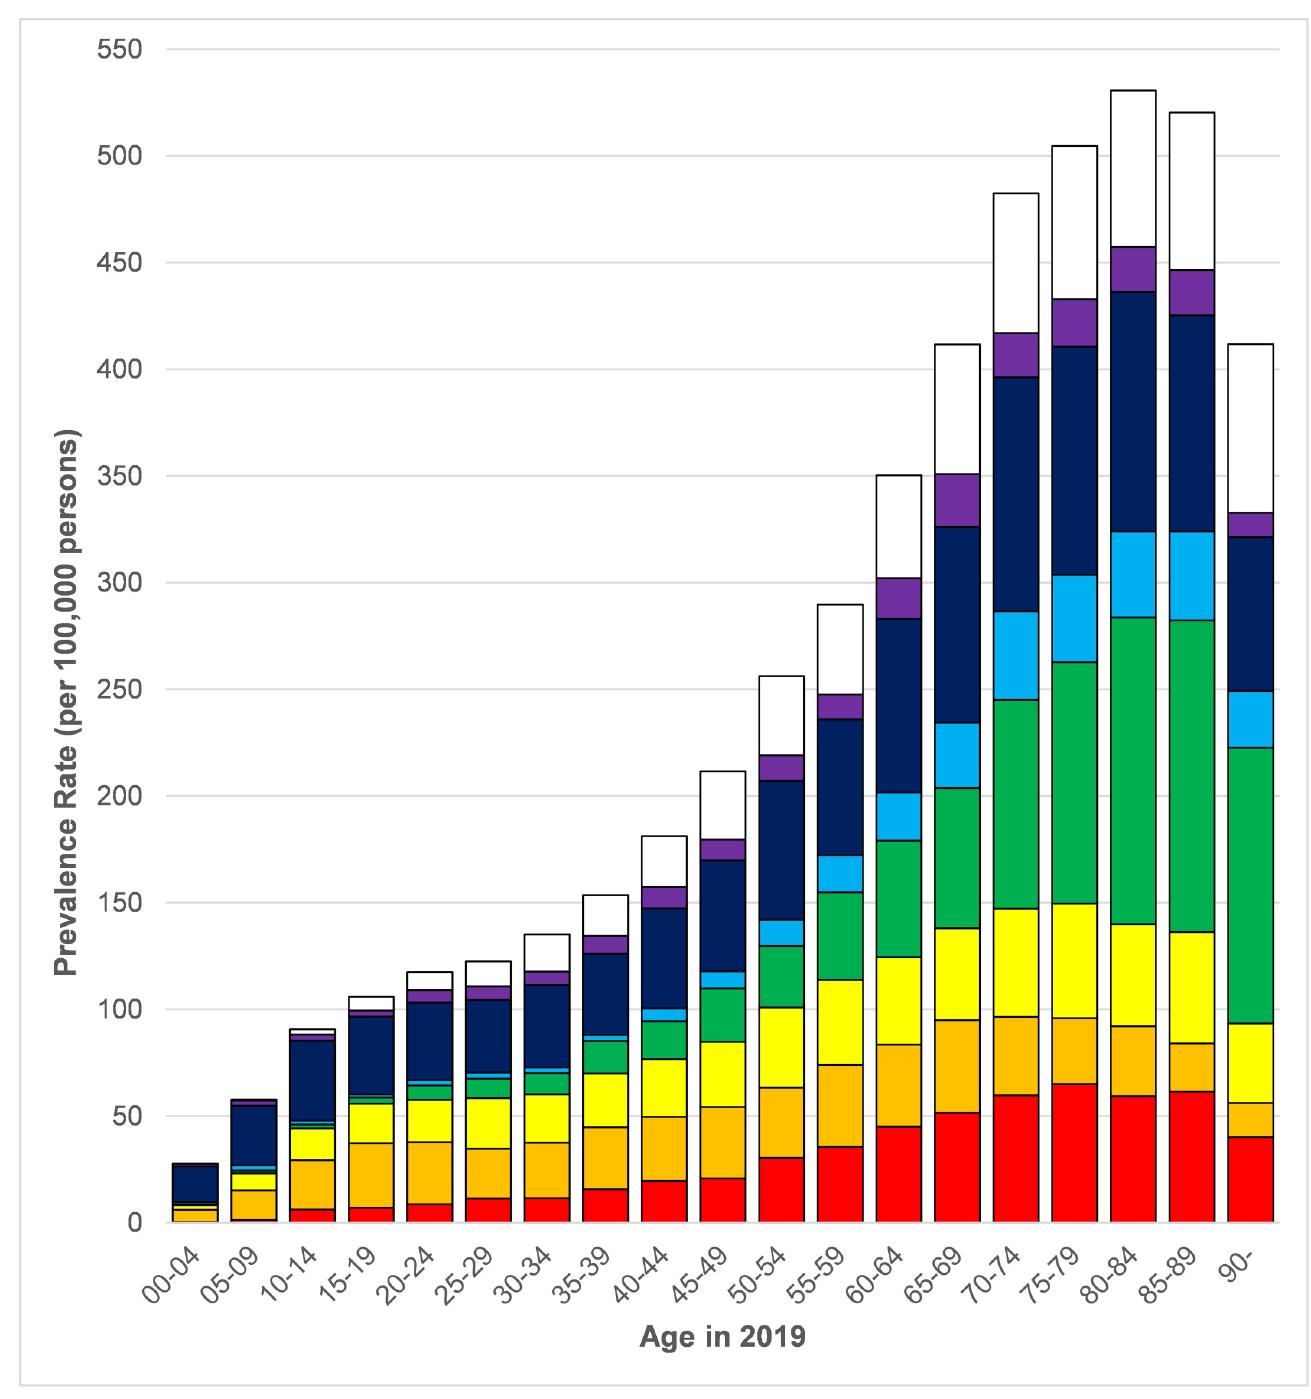
Fig 1. Prevalence rates per 100,000 persons in 2019 by 5 year-age group and type of neuromuscular disease. Red = Inflammatory myopathies, Orange = Muscular dystrophies, Yellow = Charcot-Marie Tooth disease, Green = Myasthenia gravis, Light Blue = Motor neurone disease, Dark Blue = Other neuromuscular disease, Purple = Guillain-Barre´ syndrome (recorded in last 5 years), White = Guillain-Barre´ syndrome (recorded last more than 5 years ago).